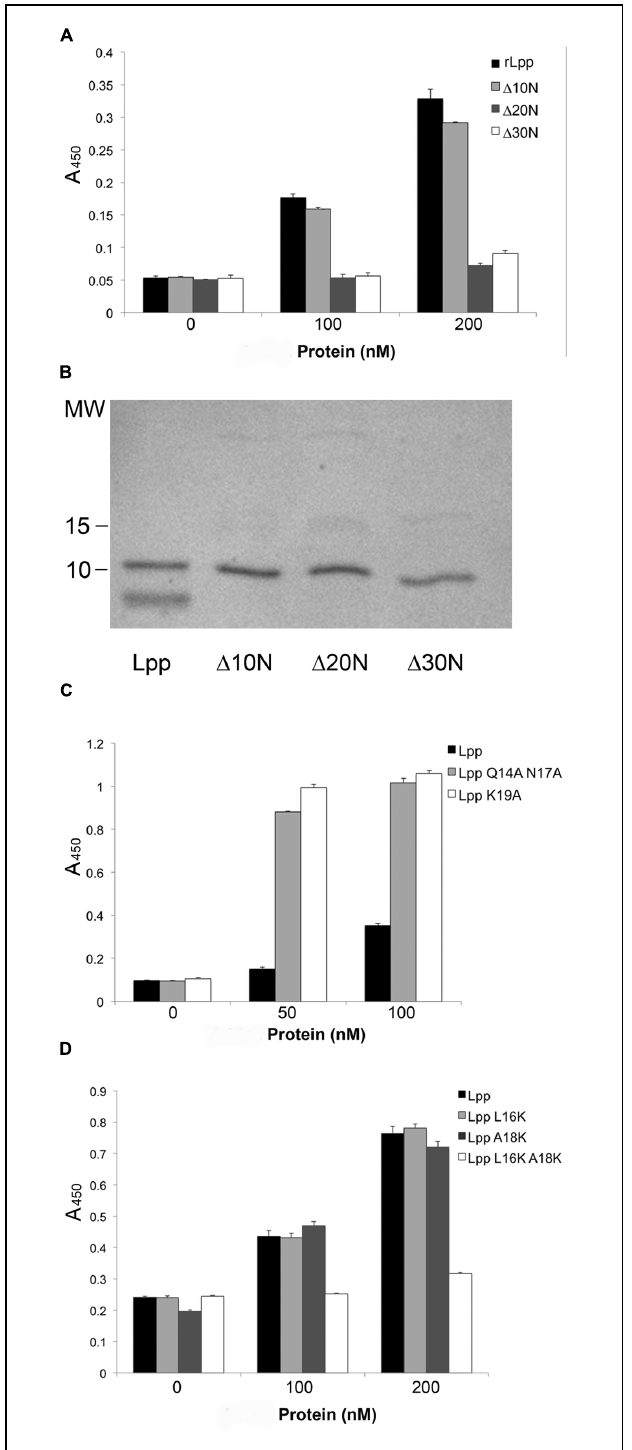
FIGURE 4 | Neutral residues near the N-terminus of Lpp are required for optimal binding of Plg by Lpp. The N-terminal truncations of Lpp were analyzed via ELISA for binding to human Plg (A) , and their ability to be recognized by our α Lpp was confirmed by Western blot (B) . ELISA was performed to assess binding of Lpp by site-directed mutagenesis variants lacking ionic (C) as well as non-polar amino acids (D) .